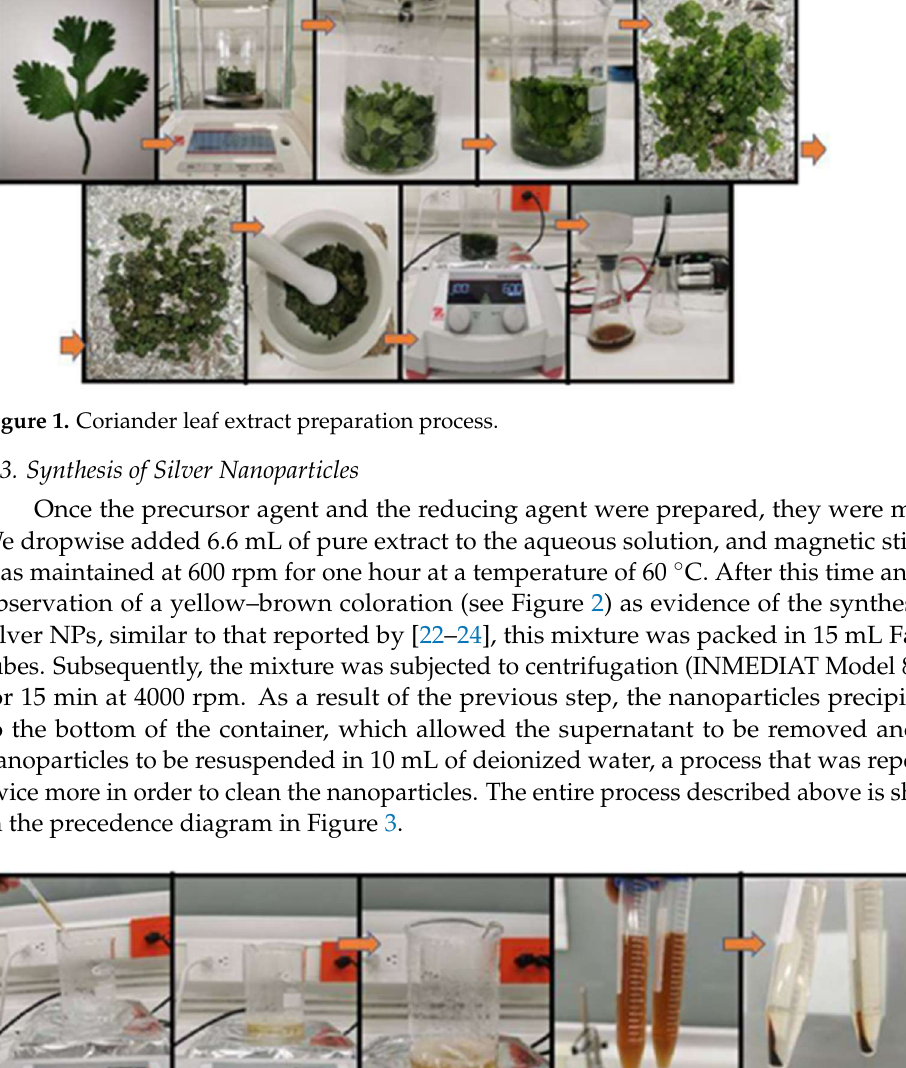
Figure 3. Precedence diagram illustrating the complete process of AgNP synthesis. 2.4. Techniques of Characterization 2.4.1. Characterization of the Extract In order to determine the functional groups present in the coriander leaf extract and recognize the components that make it a reducing agent and surfactant in the AgNP synthesis process, a drop-shaped sample was placed on a Fourier Transform infrared spectroscope cell Bruker ALPHA II (Bruker, Billerica, MA, USA, EE.UU). This equipment has a spectral resolution of 4 cm −1 and a measurement range between 400 and 4.000 cm −1 . The spectra were automatically analyzed by the OPUS software (OPUS from Bruker, Billerica, MA, USA, EE.UU). 2.4.2. Characterization of the AgNPs Suspension samples were loaded into a UV–Vis spectrophotometer and subjected to radiation in the spectral range of 200 to 1100 nm in order to obtain absorbance spectra. To determine the hydrodynamic size of the particles suspended in the deionized water, the synthesized samples were subjected to dynamic light scattering (DLS). This process was carried out with Malvern Zsizer equipment (Malvern., Almelo, Overijssel, NLD), which a measuring range between 0.3 nm and 10 µm. Additionally, SEM (Tescan, Brno, Moravia, CZE) measurements were performed on the obtained samples in order to determine the size of the nanoparticles and contrast it with the results obtained by DLS. These measurements were conducted with a Tescan Vega 3 LMU scanning electron microscope (Tescan, Brno, Moravia, CZE) at a magnification range of 2.5× to 1,000,000× and a voltage of 30 kV. X-ray diffraction (XRD) (Bruker, Billerica, MA, USA, EE.UU) tests were performed on the obtained NPs in order to determine their structural characteristics. For this purpose, we used a Bruker Advance diffractometer with a measurement range of 20